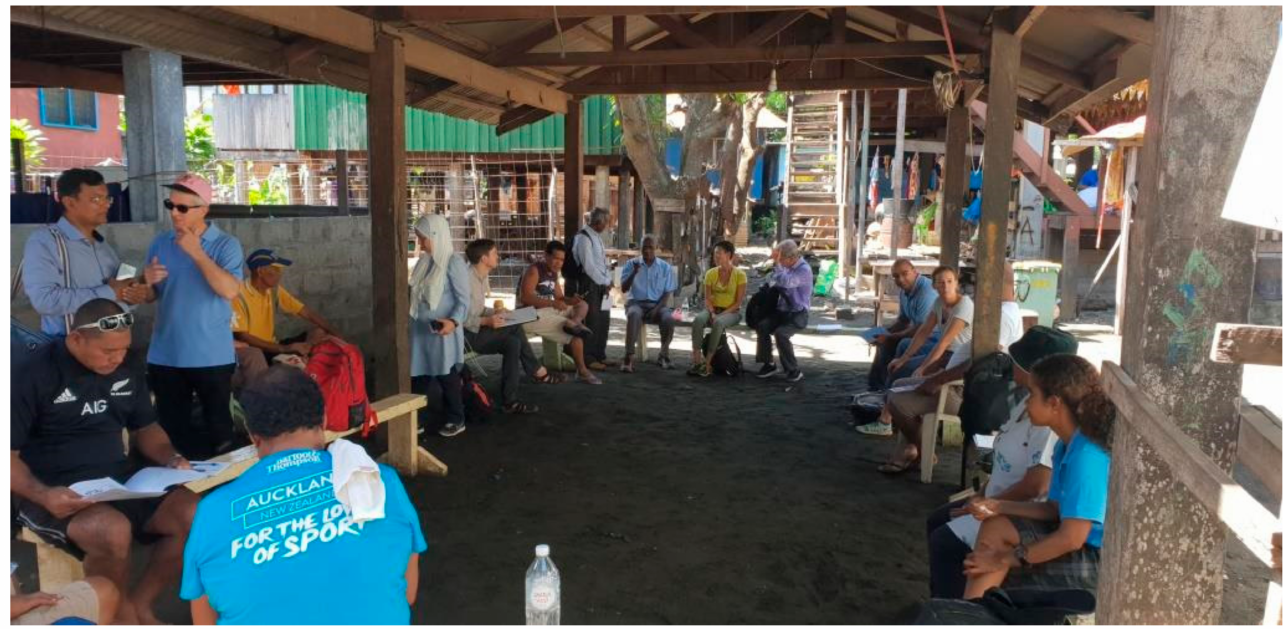
Figure 2. Community workshop in Ontong Java settlement (Photo credit: